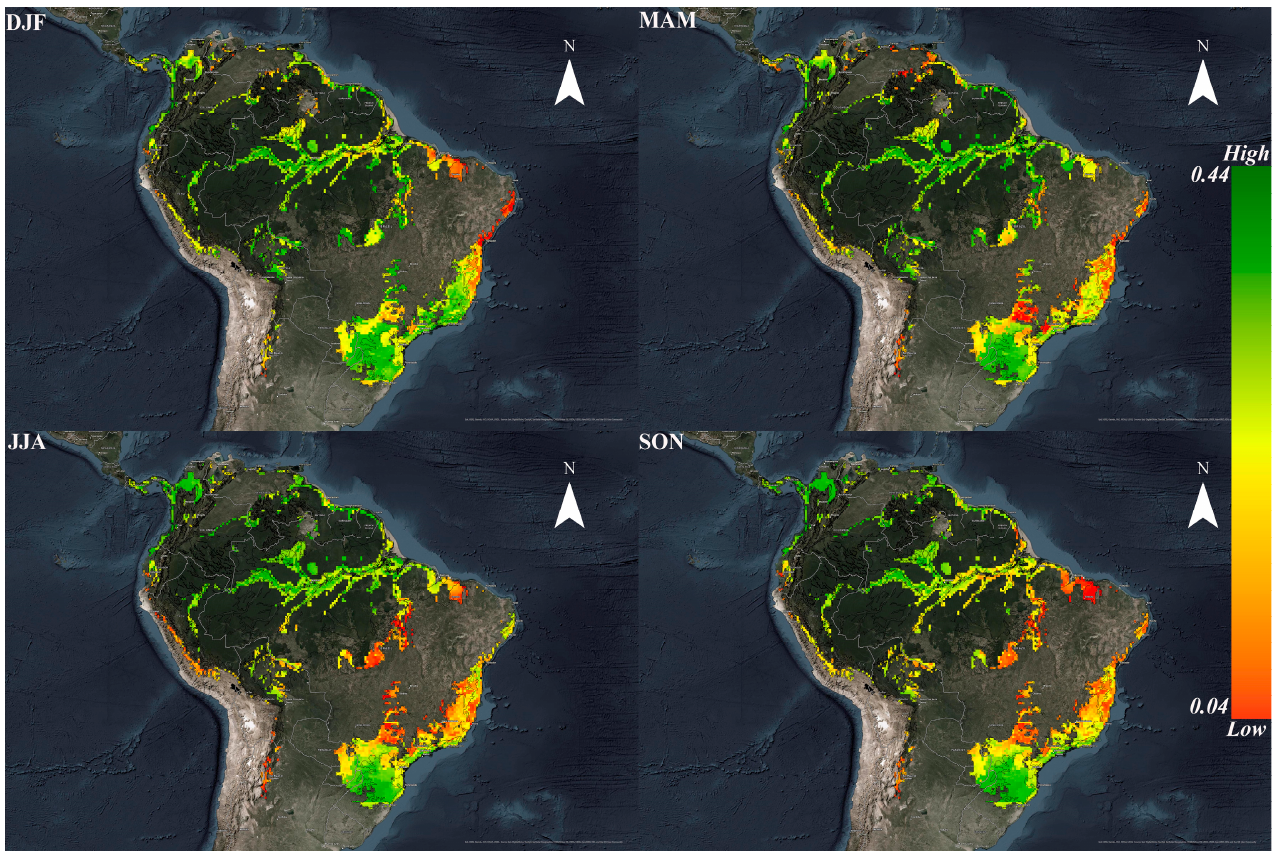
Figure 5. VSM spatial climate variation (m 3 m − 3 ) for 2007.